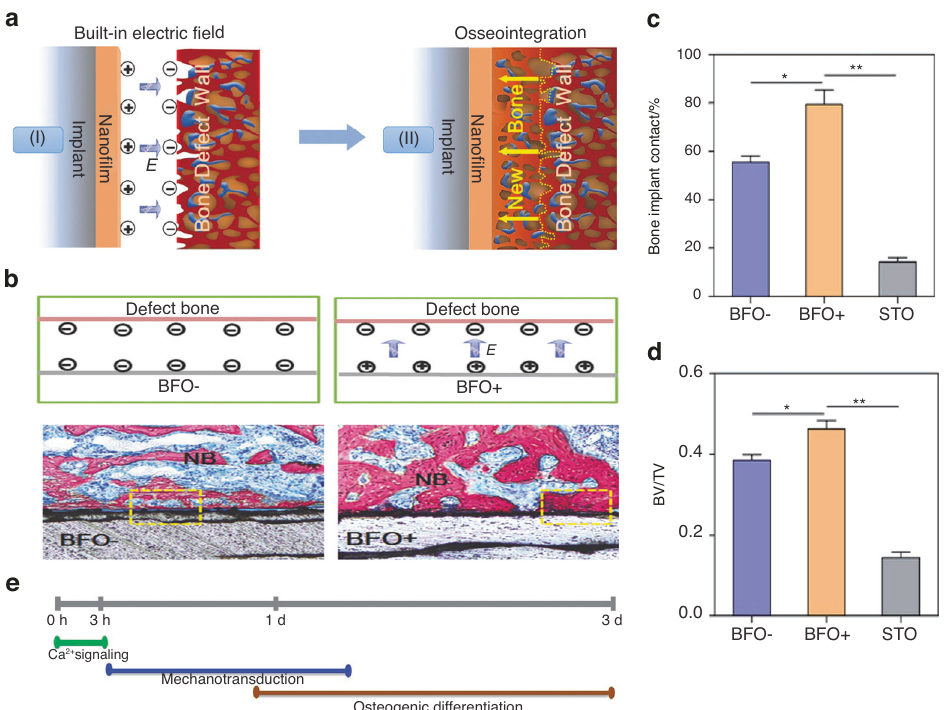
Fig. 10 Built ‐ in electric fi elds dramatically induce enhancement of osseointegration and bone defect regeneration. a Illustration showing the built-in electric fi elds promote implant osseointegration: A built-in electric fi eld is constructed among the endogenous electronegative bone defect wall and the electropositive ferroelectric BiFeO 3 (BFO) nano fi lm implant surface. Thus, the rapid and high-quality osseointegration was induced on the implant. b Schematic illustration of the built-in electric fi elds forming among BFO + nano fi lm implants and bone. And the corresponding histological analysis at 2 weeks post-implantation, which showing better osseointegration on BFO + nano fi lm implants (NB: nascent bone). c Diagram of quantitative analysis of bone-implant contact (BIC) values. d Diagram of different bone volume/total volume (BV/ TV) on the basis of histomorphometry analysis (* P < 0.05, ** P < 0.01). e Graphical summary of phases of BFO + nano fi lm-trigged osteointegration. Reproduced with permission. 28 Copyright 2017,